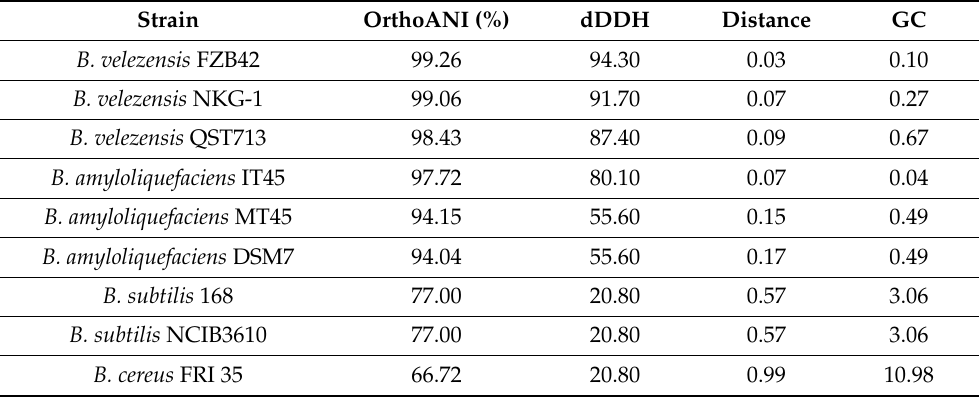
Table 3. Genomic comparisons of different Bacillus species using the OAT software for ANI% determination using OrthoANI and the Genome-to-Genome Distance Calculator (GGDC) to calculate dDDH and distance values between the